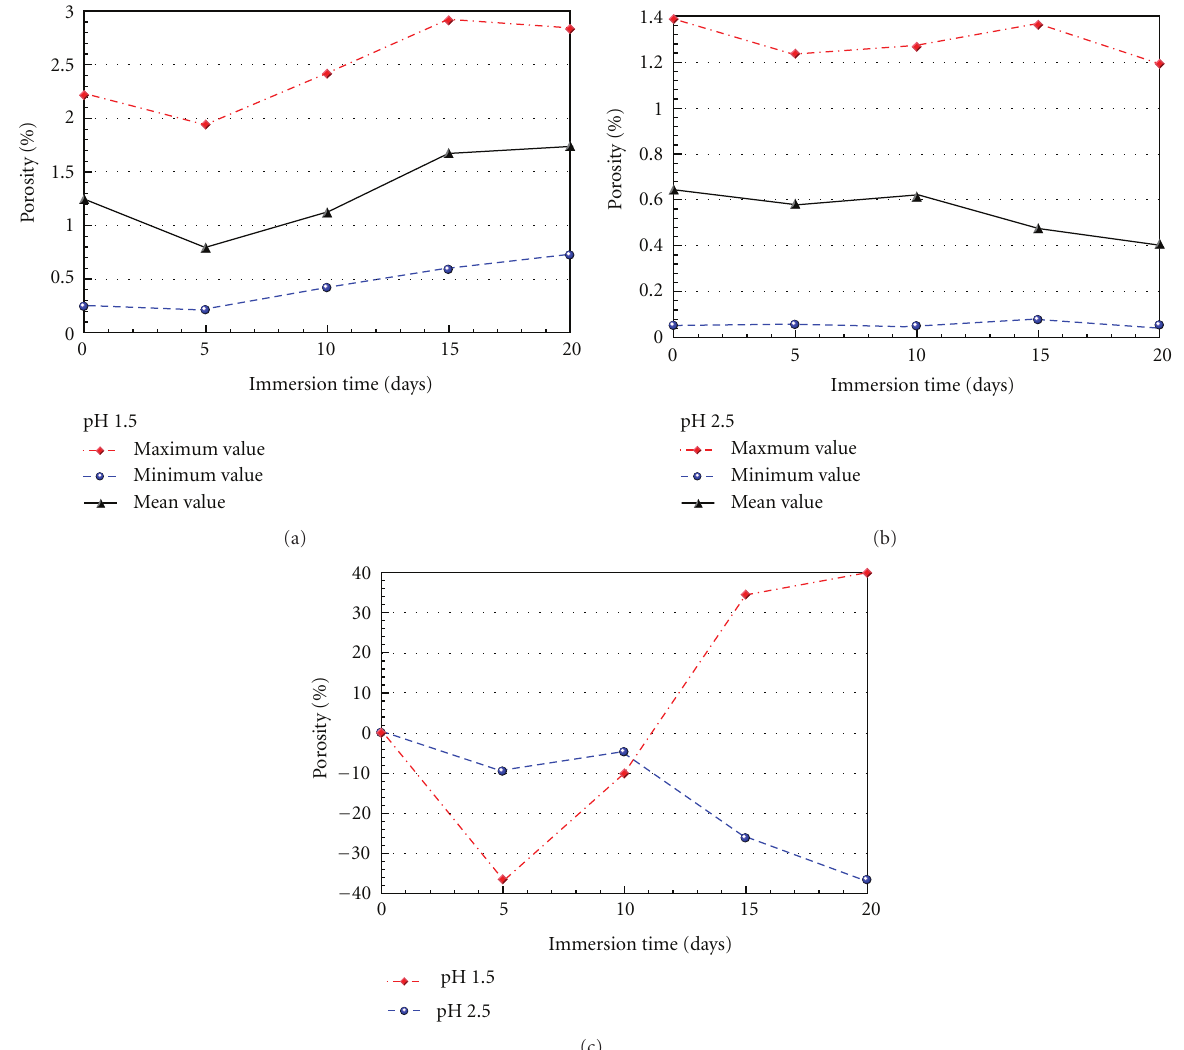
Figure 11: Relation between porosity ratio of concrete specimen and immersion